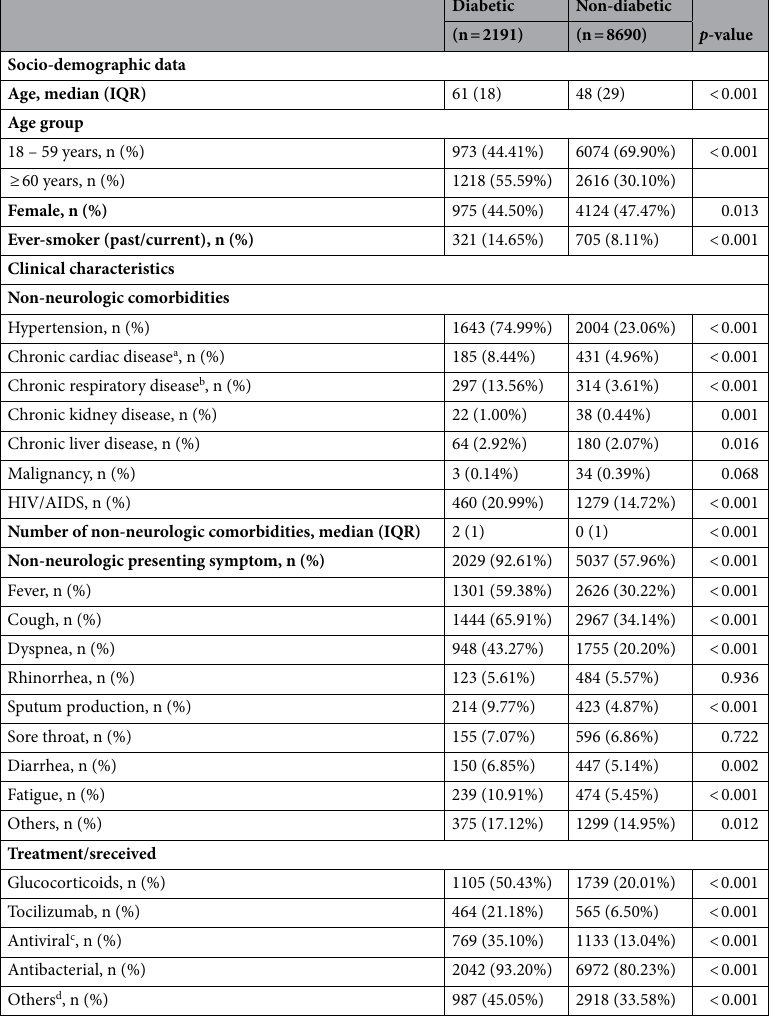
Table 1. Baseline characteristics stratified by history of diabetes. a Includes heart failure, coronary artery disease, prior history of myocardial infarction, and other cardiac conditions. b Includes bronchial asthma, chronic obstructive pulmonary disease (COPD), restrictive lung disease, and other pulmonary conditions. c Includes remdesivir, lopinavir, ritonavir. d Includes chloroquine, hydroxychloroquine, convalescent plasma, and other